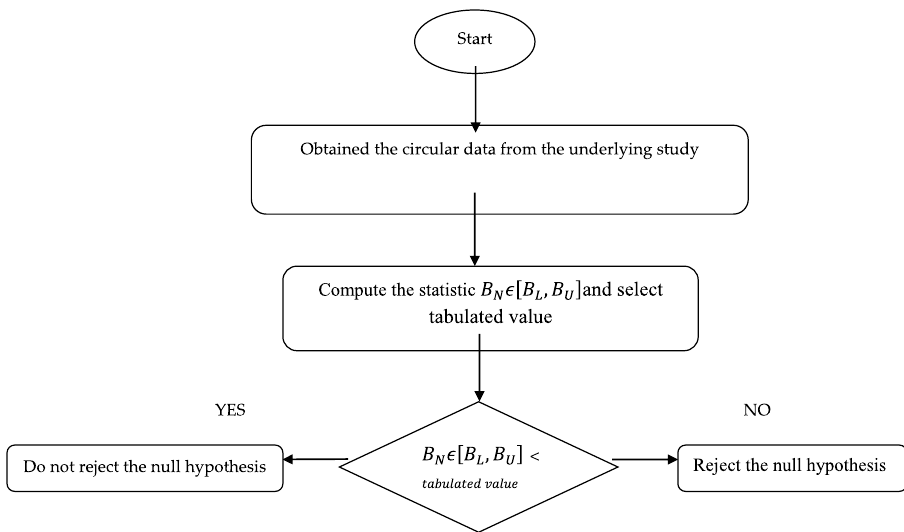
Fig. 1 The operational process of the proposed NMWW